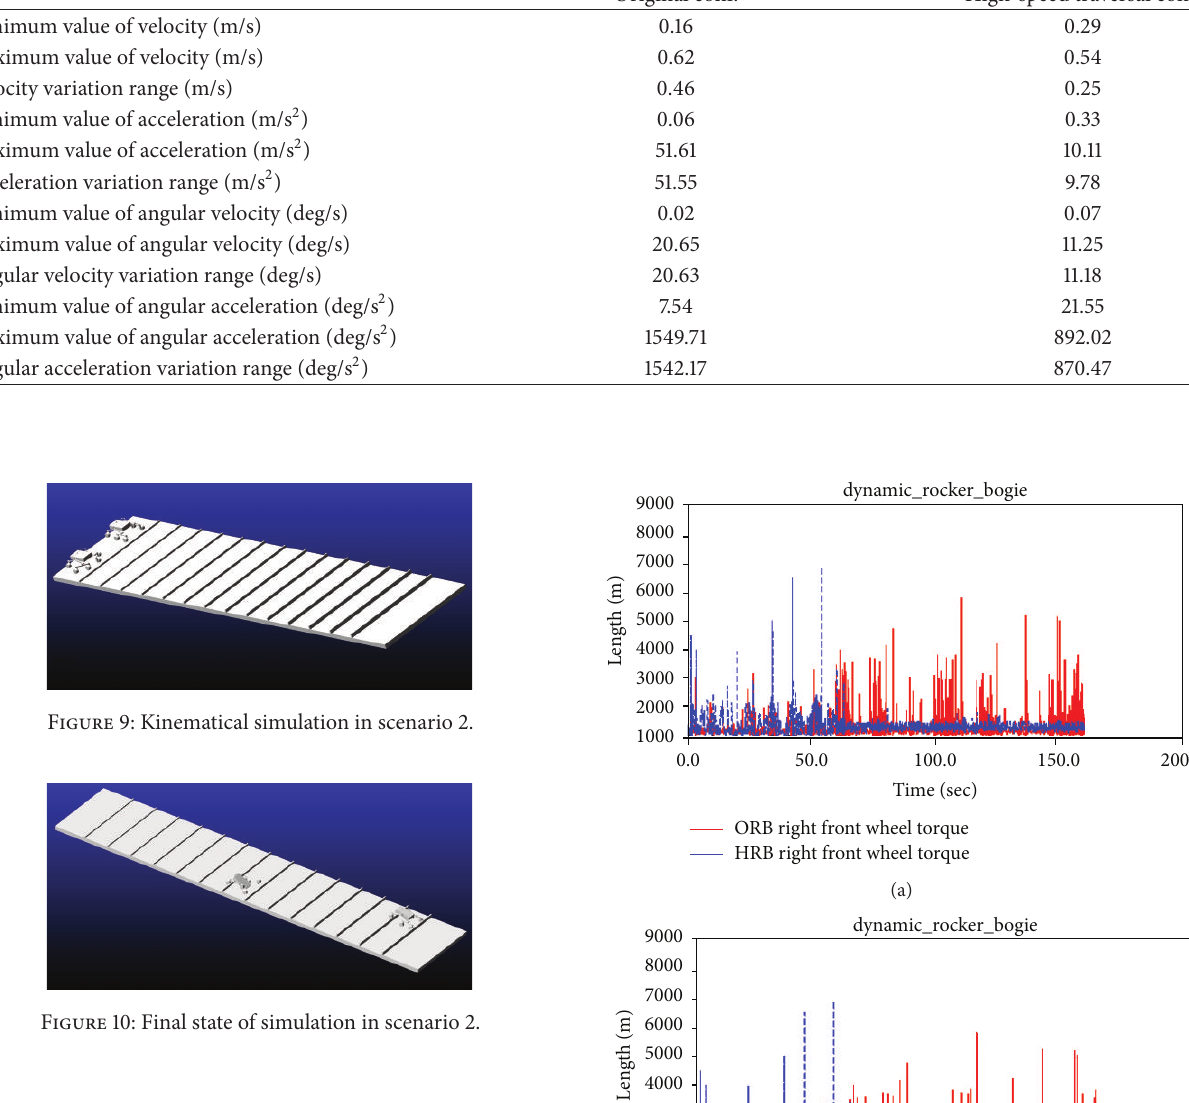
Table 4: Data from the velocity, acceleration, angular velocity, and angular acceleration variation. Original conf.